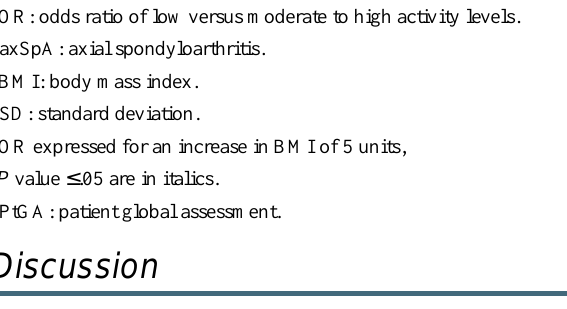
Clusters according to number of steps per dayClusters according to moderate to vigorous activity durationFactors associated with a low